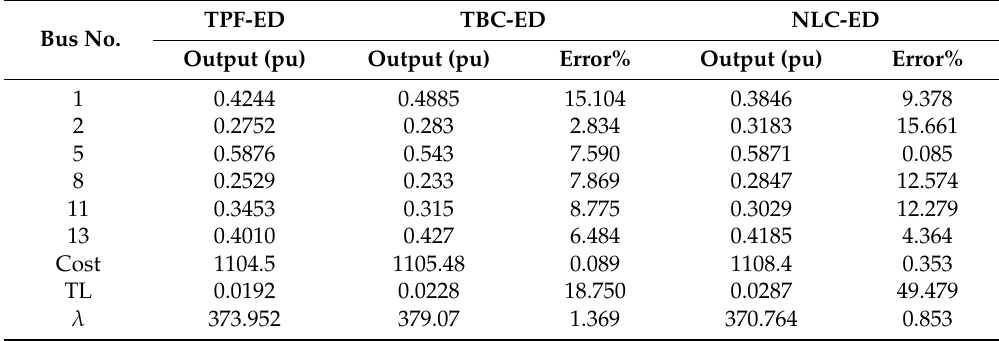
Table 12. Percentage of nonconforming system demand change in each bus for the IEEE 30-bus system.